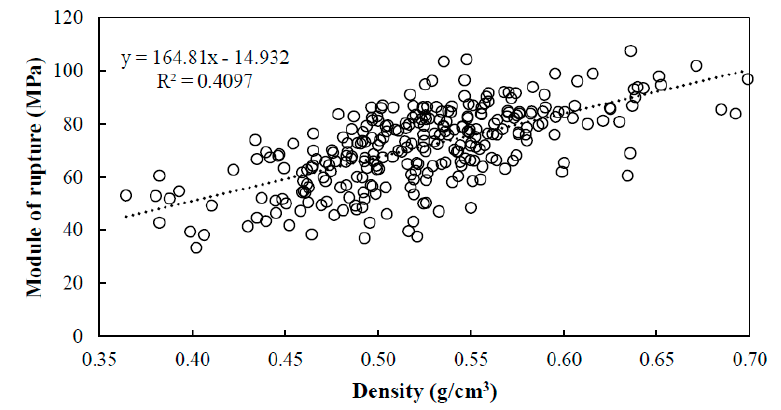
Figure 9. Relationship between module of rupture and density.